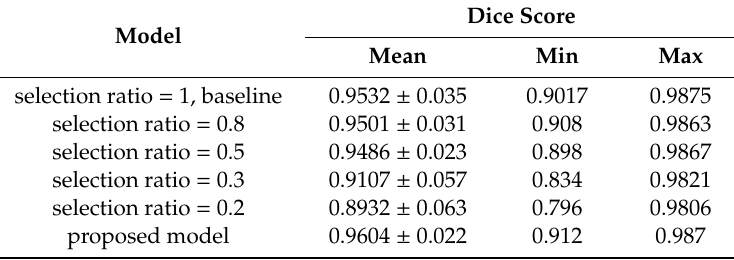
TableA3. Liversegmentationresultsontestdatasetbasedondi ff Table A3. Liver segmentation results on test dataset based on different selection ratio using U-Net model.